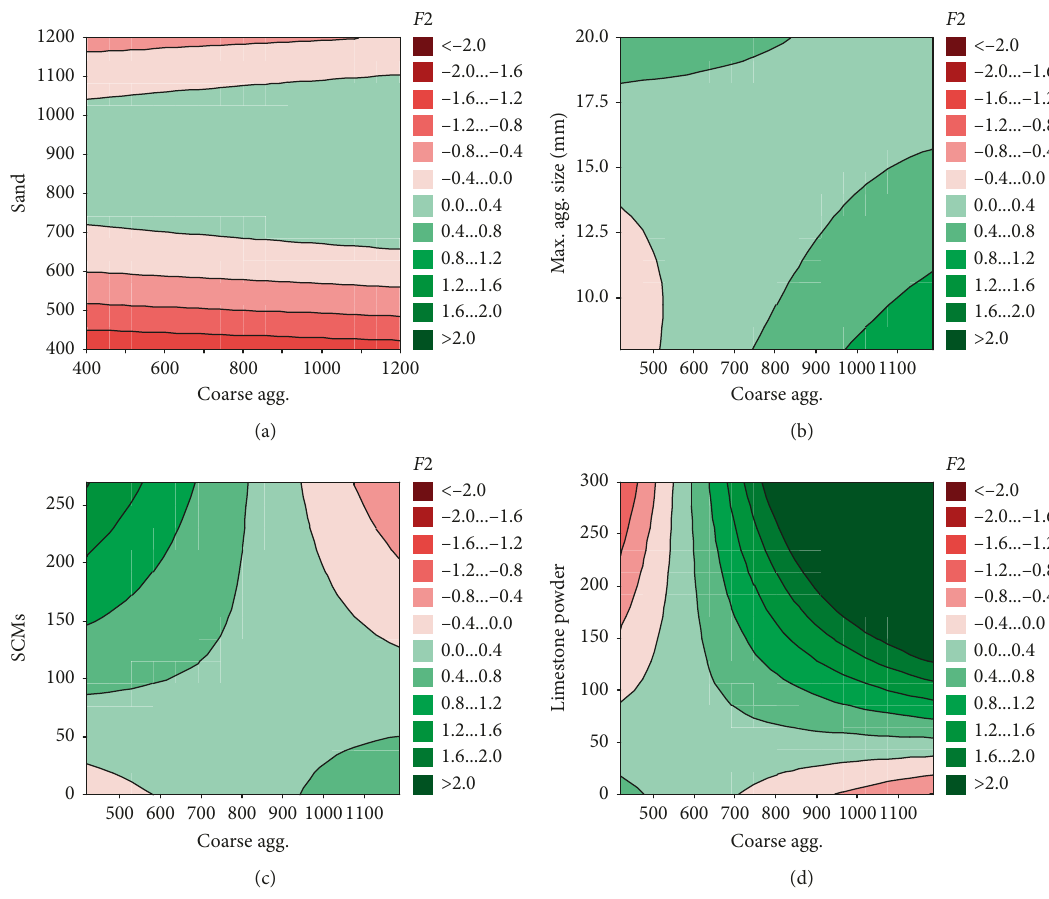
Figure 6: Effect of the aggregates and powders on the flow spread ( F